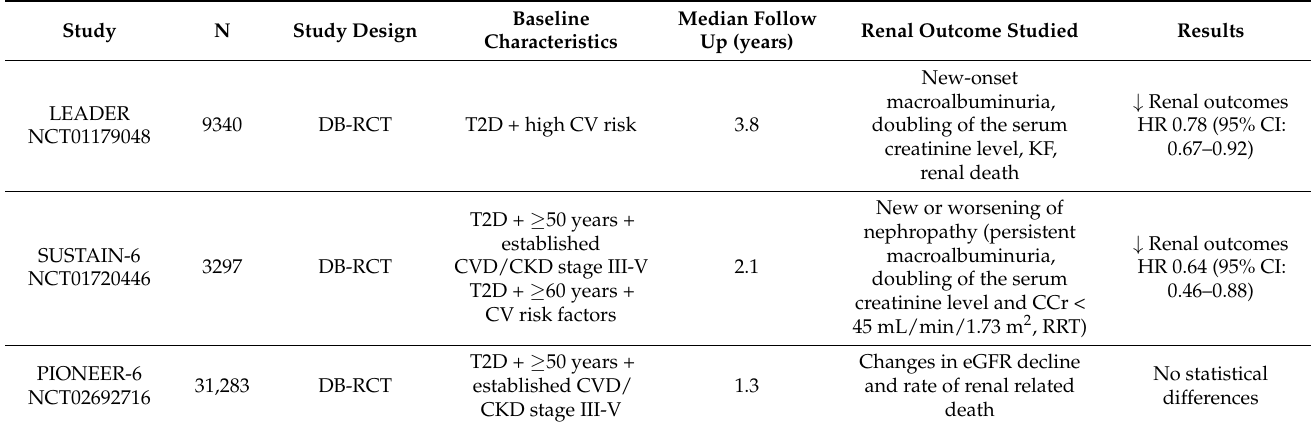
Table 1. GLP1-RAs and renal outcomes in main clinical